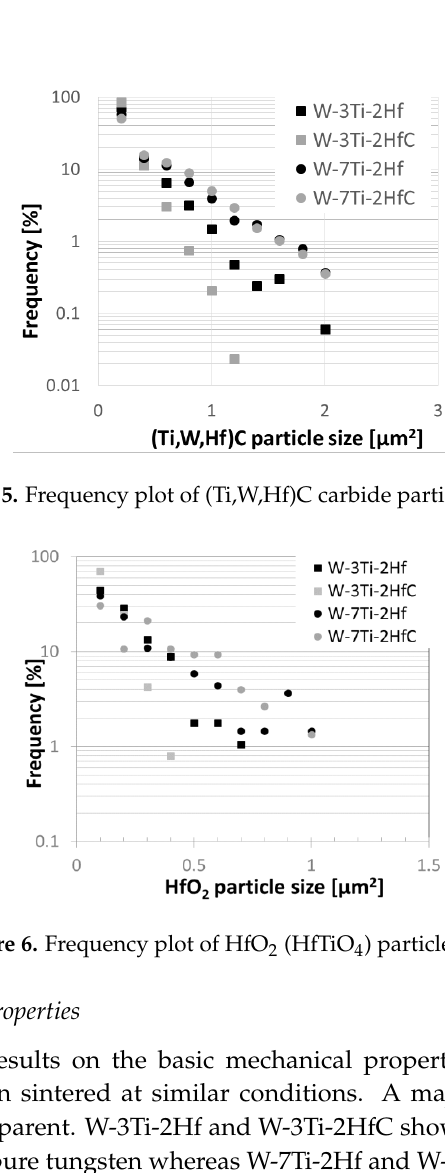
Figure 4. Frequency plot of matrix grain sizes.